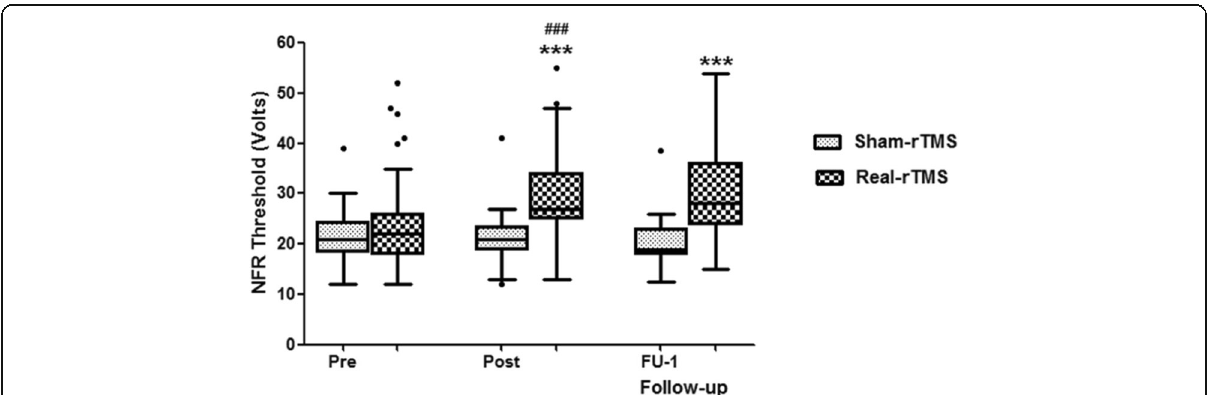
Fig. 4 : Effect of rTMS on spinal nociception (NFR) in FMS. Central nociception assessed by nociceptive flexion reflex (NFR) thresholds in Sham ( n = 41) and Real-rTMS ( n = 45) group at each time points;pre, post and follow up (FU-1 = 15 days, FU-2 = 3 months and FU-3 = 6 months post- rTMS). Hash (#) symbol indicates within group p value. Asterisk (*) symbol indicates p value between Sham-rTMS and Real-rTMS group. * p or # p < 0.05; ** p or ## p < 0.01; *** p or ### p <